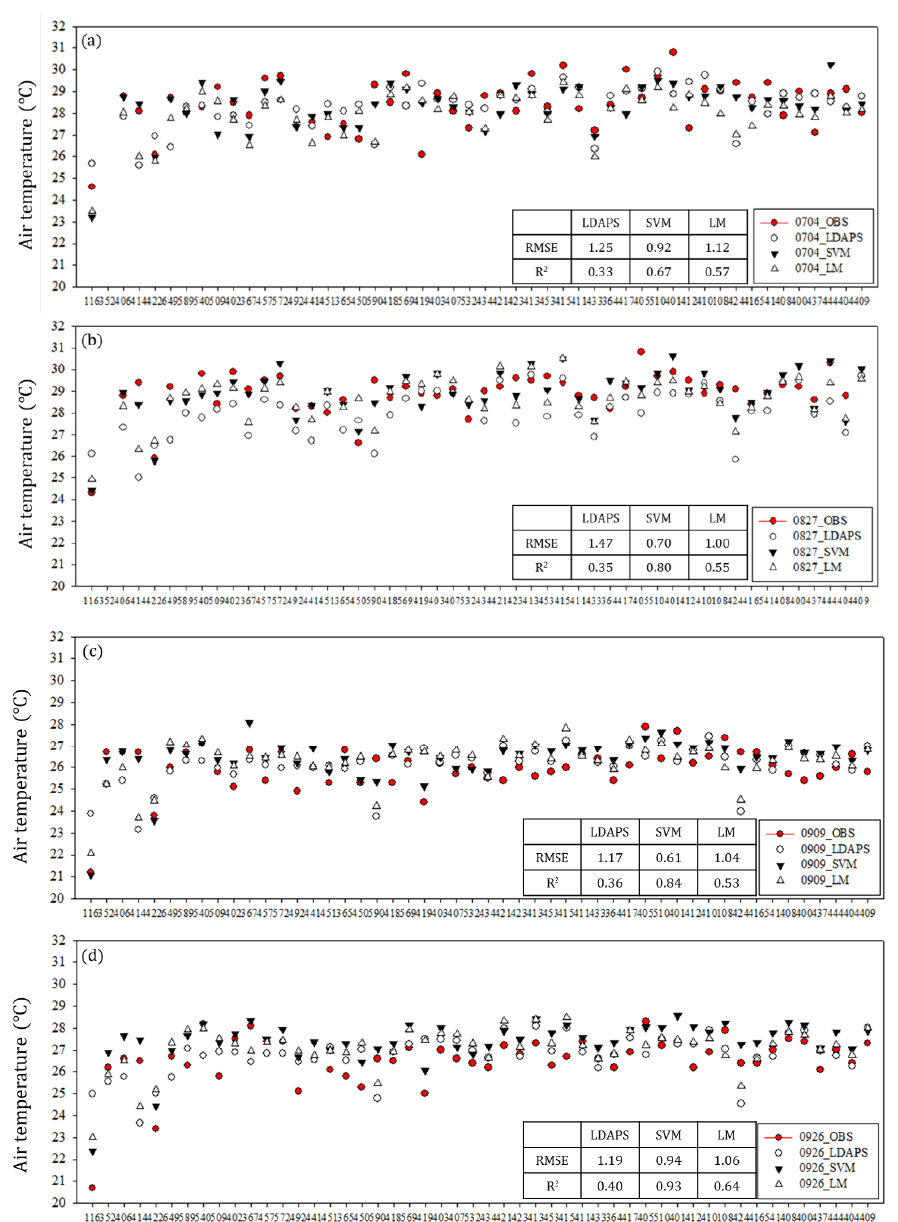
Figure 12. Comparison of the distribution of estimated (gray) and observed (red) air temperatures at 15:00 LST during clear days. The four case days are ( a ) 4 July; ( b ) 27 August; ( c ) 9 September; and ( d ) 26 September. The x-axis represents sequentially sorted AWSs, according to impervious area ratios.